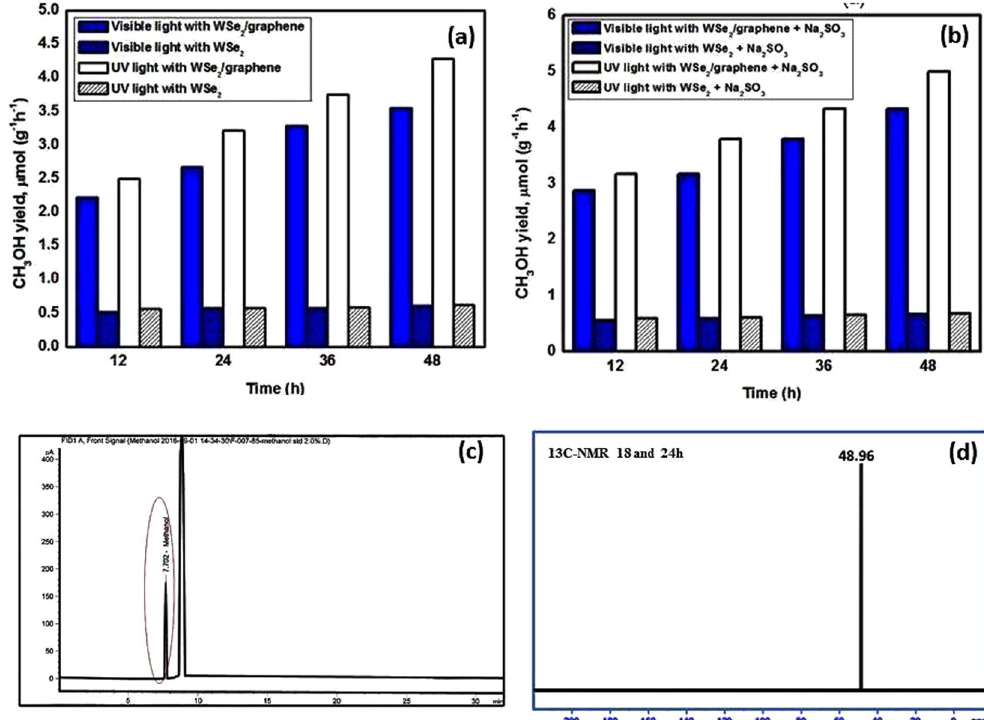
Figure 8. The methanol yields in the photocatalytic reduction of CO 2 under UV/visible light irradiation by using pure WSe 2 and WSe 2 -graphene nanocomposits as phtocatalyst ( a ) without Na 2 SO 3 , ( b ) with Na 2 SO 3 ( c ) GC chromatogram of photoreaction using WSe 2 -graphene, after 48 h and (d) 13 C NMR (Proton decoupled).